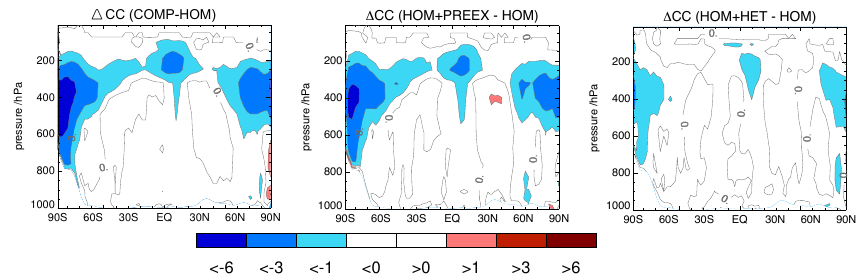
Fig. 5. Annual and zonal mean differences of cloud cover as a function of pressure and latitude for the different simulations COMP,